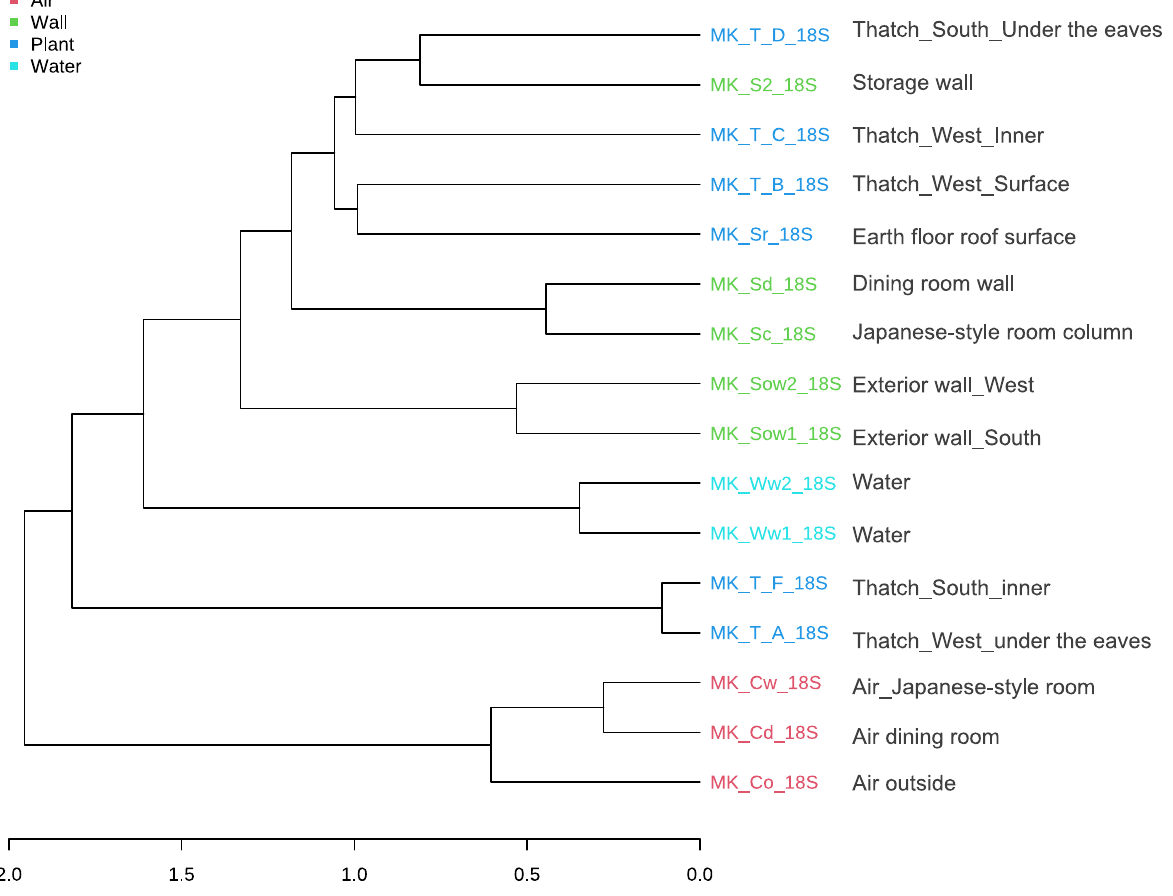
Figure 10. Hierarchical clustering of the eukaryotic community based on distance measurements using the Bray-Curtis dissimilarity index and a clustering algorithm using the Ward distance. The samples from the wall and thatch could not be readily distinguished.